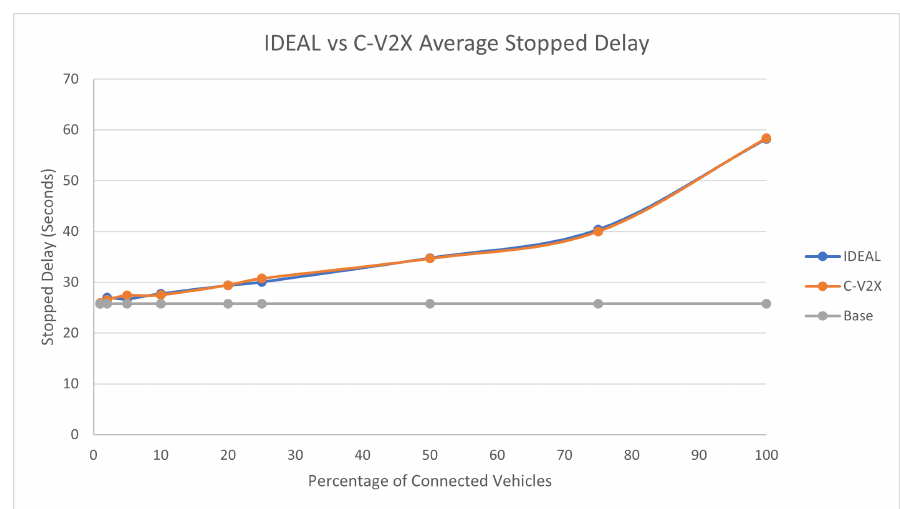
Figure 12. Average network-wide Stopped Delay of Energy-Efficient dynamic routing application using IDEAL and C-V2X communication on LA road network with traffic demand of scale factor 0.5.